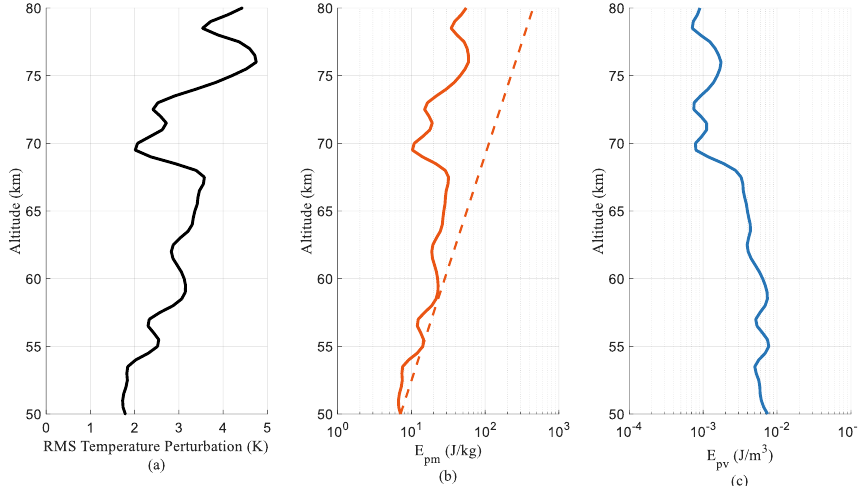
Figure 2. Temperature perturbation RMS profile ( a ), potential energy mass density E pm profile and the red dotted line is the E pm profile of the conservative AGWs ( b ), and potential energy volume density E pv profile ( c ) on 27 October 2014.